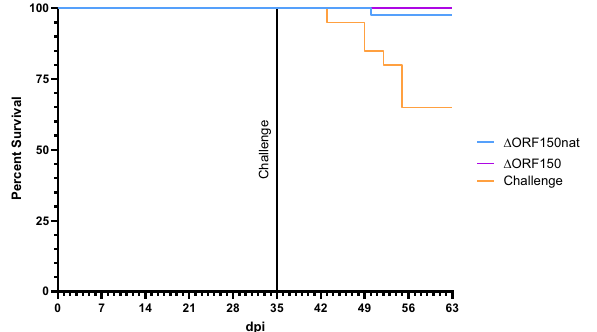
Fig. 5 Impact of ORF150 in vivo. Direct impact of ORF150 deletion on virulence of KHV. Carp were infected by immersion with 10 5 TCID 50 /mL of engineered KHV-T recombinants possessing a com- plete deletion of ORF150 (purple line), the naturally occurred partial deletion of ORF150 inserted into wildtype background (blue line), or challenge infection wildtype KHV-T (orange line). Shown are the survival rates after wild-type challenge at day 35 p.i.